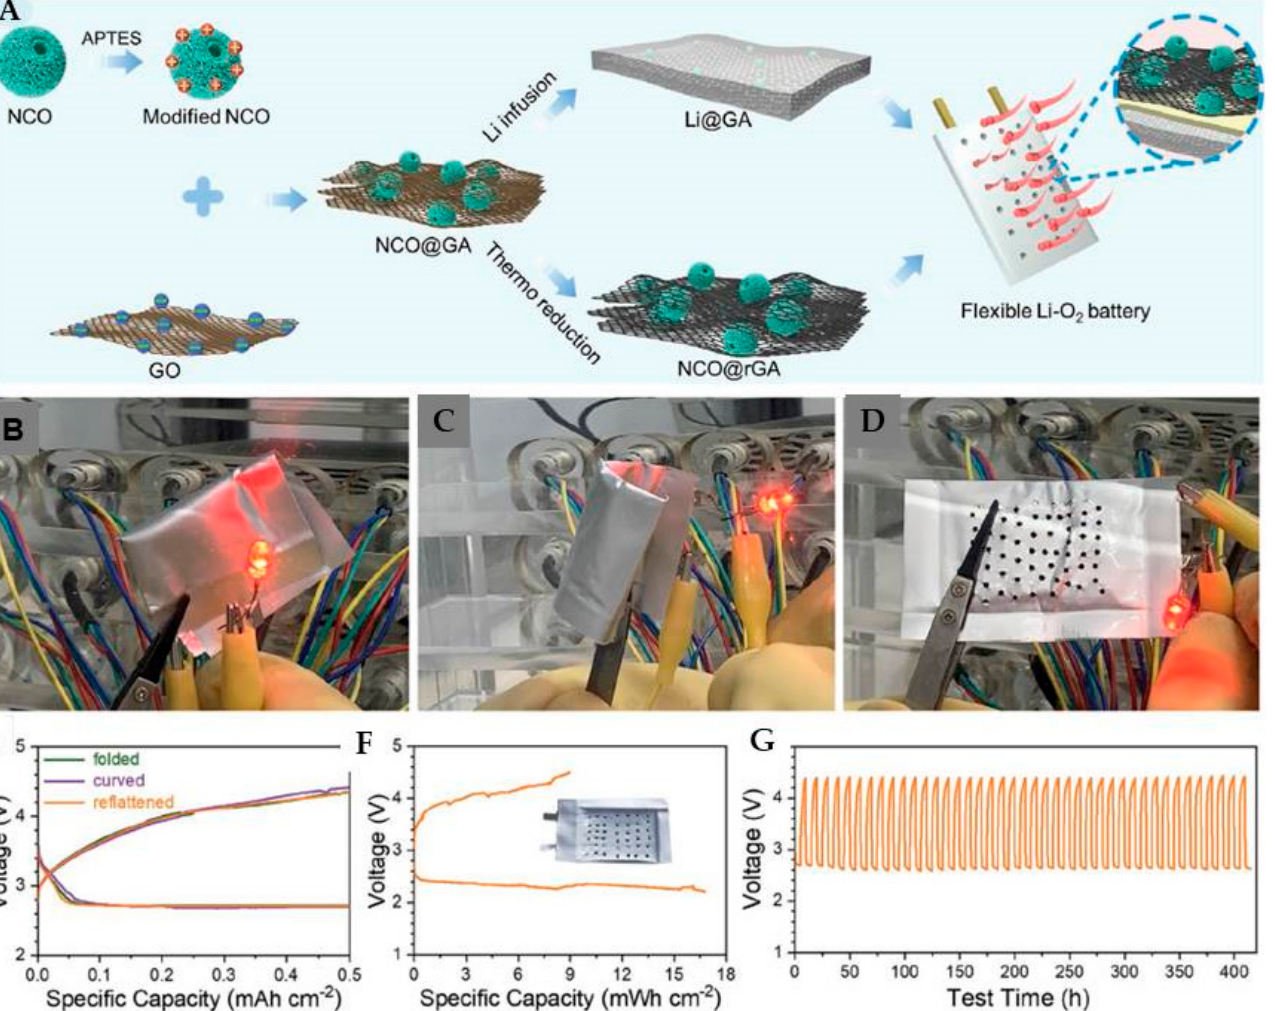
Figure 3. ( A ) The synthesis of an anode (Li@GA) and oxygen cathode (NCO@rGA) derived from NCO@GA for flexible Li-O 2 battery (GA stands for graphene oxide aerogel). ( B ) A folded, ( C ) curved, and ( D ) reflattened Li-O 2 flexible pouch cell shows the lightening of LEDs. ( E ) The corresponding specific capacities and charge/discharge profiles of ( B – D ) cells have stable performance at 0.1 mA cm − 2 . ( F ) The pouch cell of Li@GA||NCO@rGO charging and discharging curves at 0.1 mA cm − 2 and 2.2 and 4.5 V. ( G ) Cyclic performance of the cell as voltage vs. time graph. Reprinted/adapted with permission of ref. [36]. Copyright 2020, copyright Wiley-VCH.